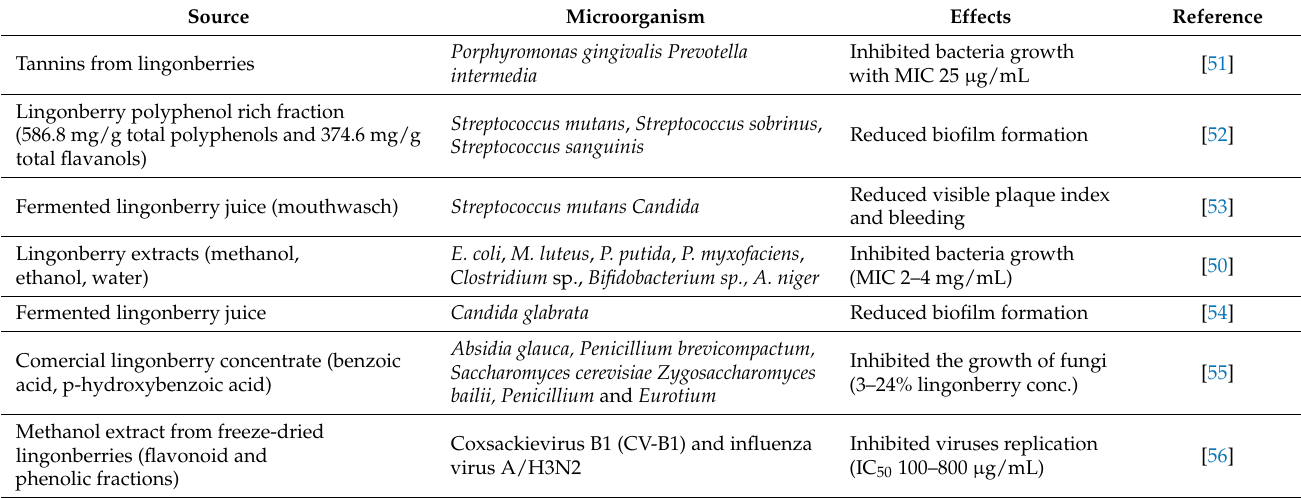
Table 3. Antimicrobial activities of lingonberry fruit